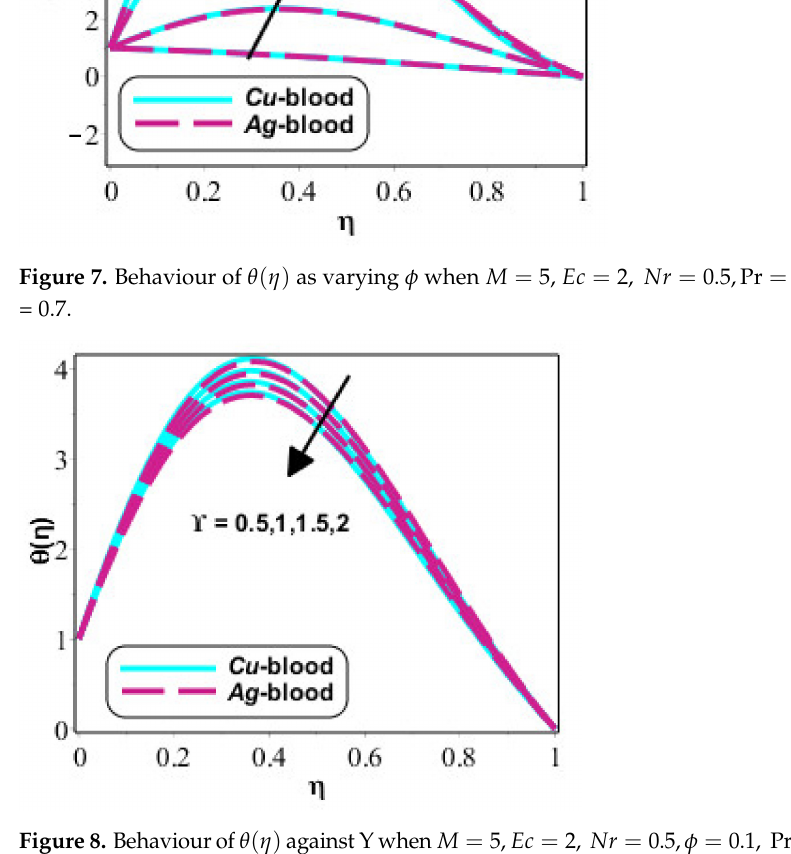
Figure 8. Behaviour of θ ( η ) against Y when M = 5, Ec = 2, Nr = 0.5, φ = 0.1, Pr = 3.9, β i = β e = 0.7.